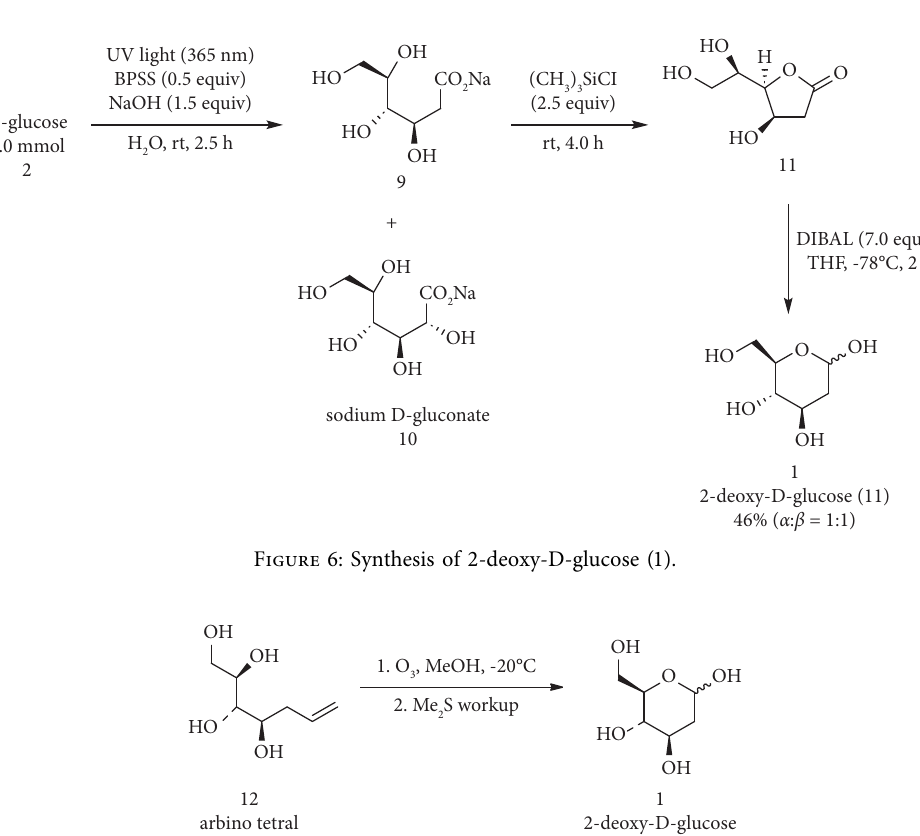
Figure 7: Synthesis of 2-DG by ozonolysis of tetrols 12